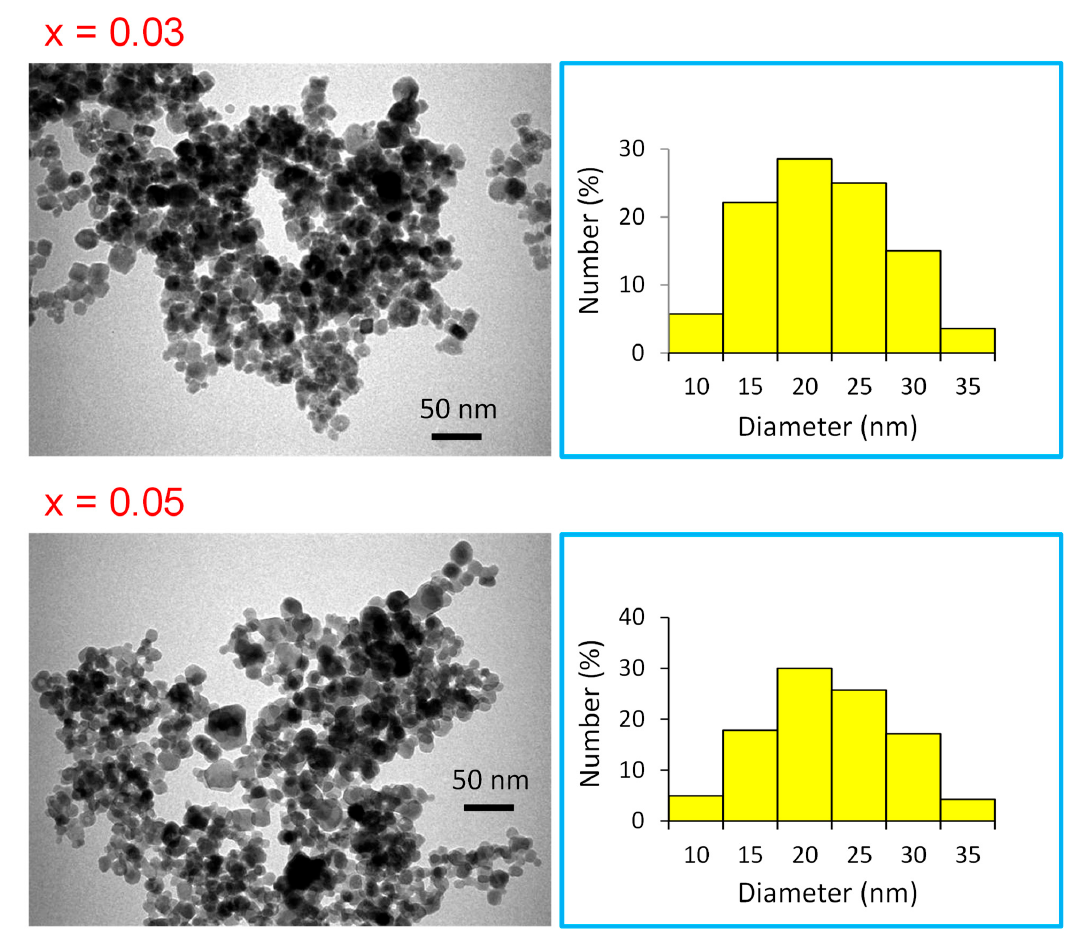
Figure 3. TEM of Mn 0.5 Zn 0.5 Eu x Sm x Fe 1.5 − 2x O 4 (x = 0.03 and 0.05) NPs.